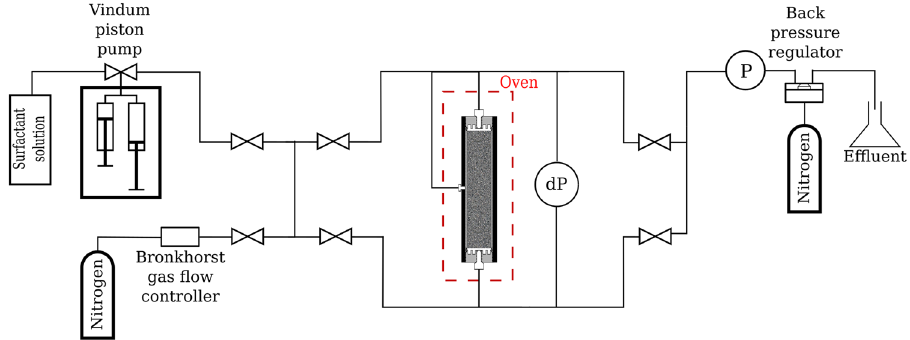
Figure 1. Schematic of the experimental